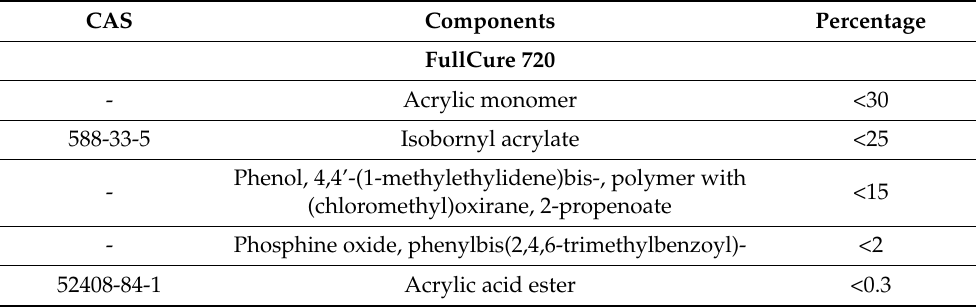
Table 2. Chemical composition of FullCure 720 [43].